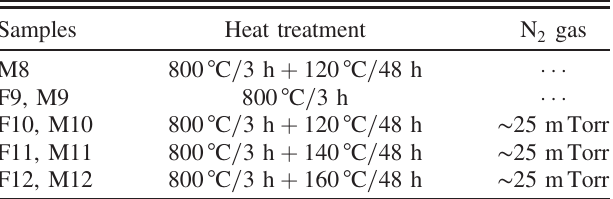
TABLE I. Summary of sample heat treatments.